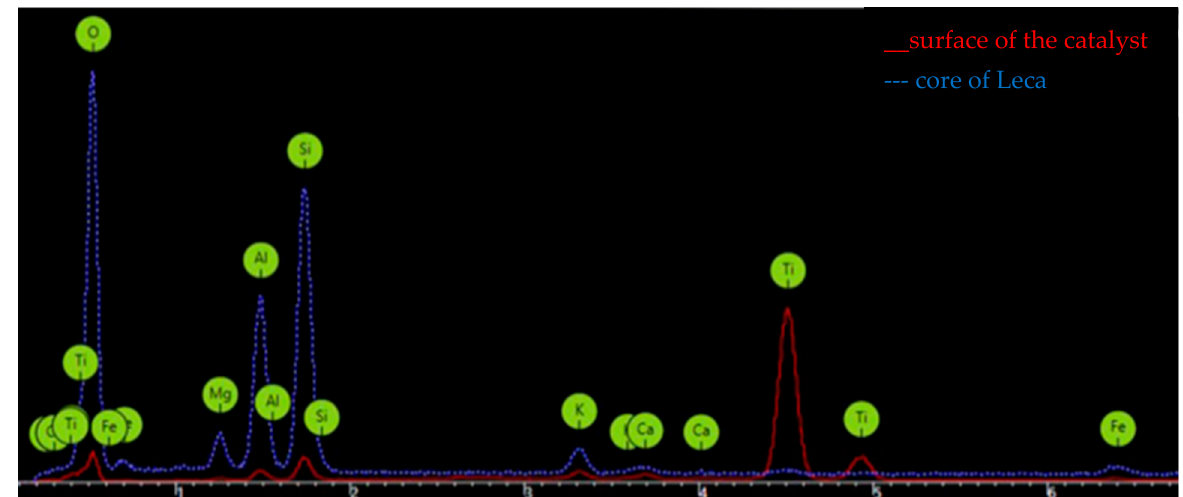
Figure 8. Elemental composition of Leca particles at the core and surface of the impregnated catalyst.